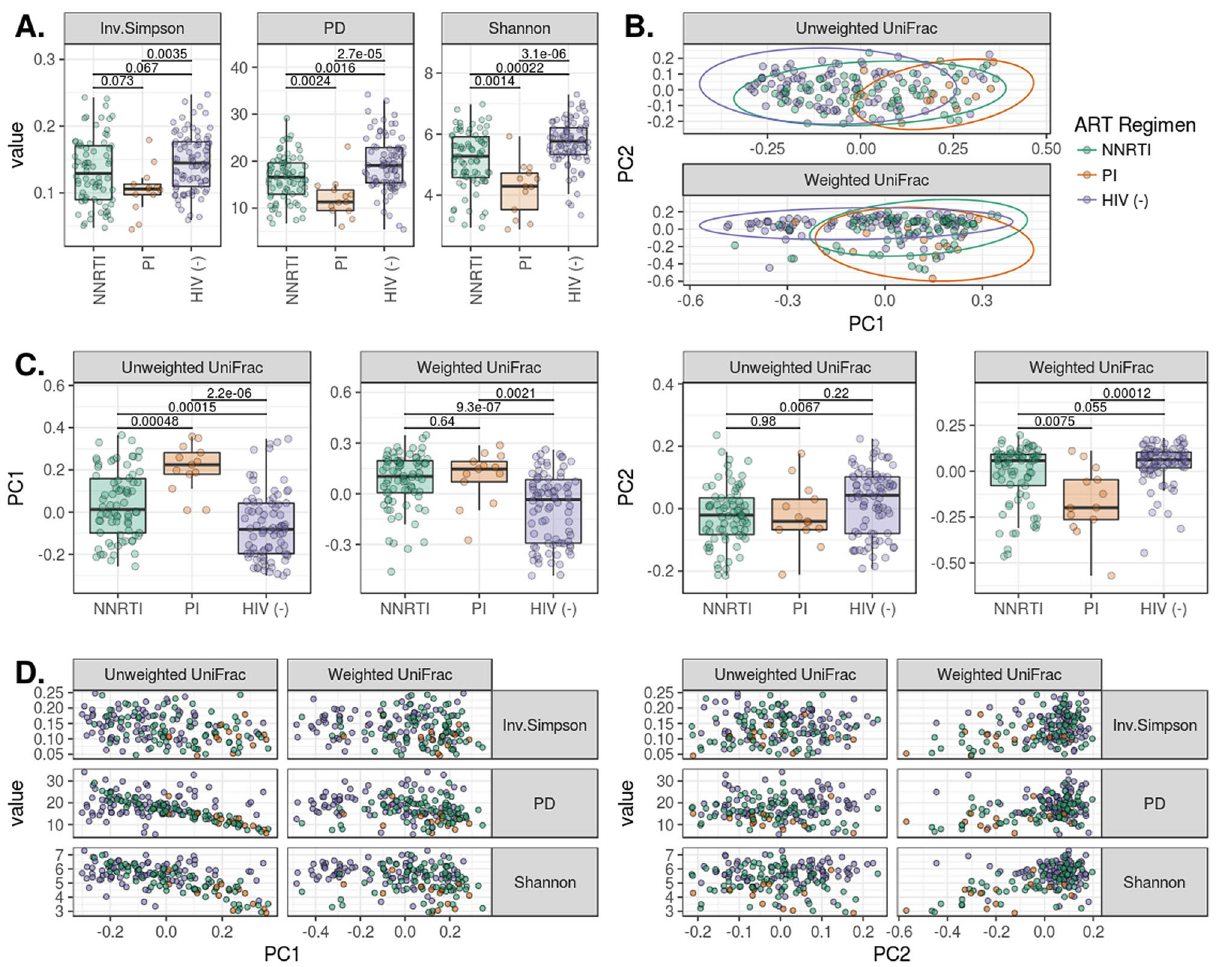
Figure 5. ART regimen-specific effects on diversity and composition. ( A ) Shows that PI treatment is associated with reduced bacterial evenness and richness when compared to HIV non-infected individuals and those on NNRTI regimens. ADONIS testing of weighted and unweighted UniFrac distances indicated differential clustering when comparing NNRTI to PI-based regimens ( p < 0.05). Differences in ordination of the UniFrac distances by ART regimen are detailed in ( C ). ( D ) Depicts the relationships between UniFrac ordinations and alpha